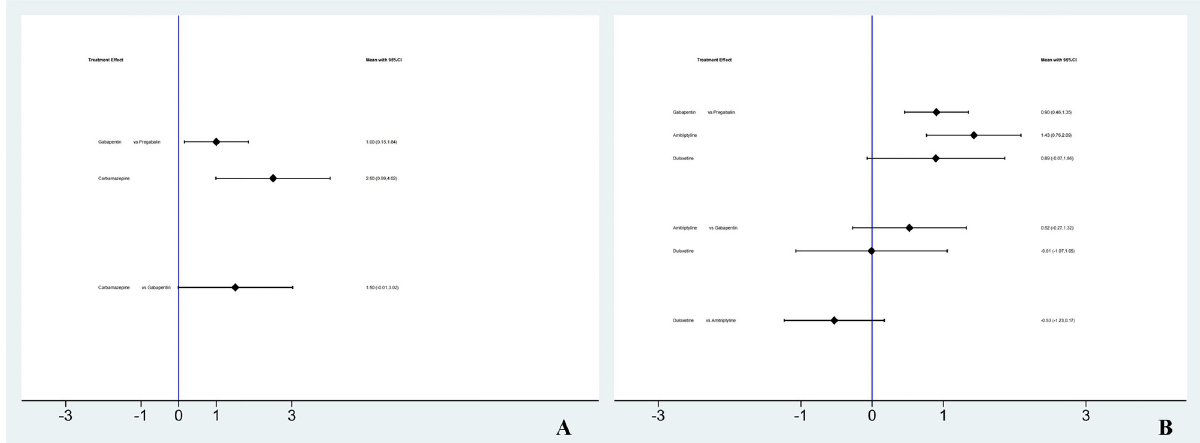
Fig 5. Network meta-analysis of NRS and HAMD scores. (A: NRS; B: HAMD).